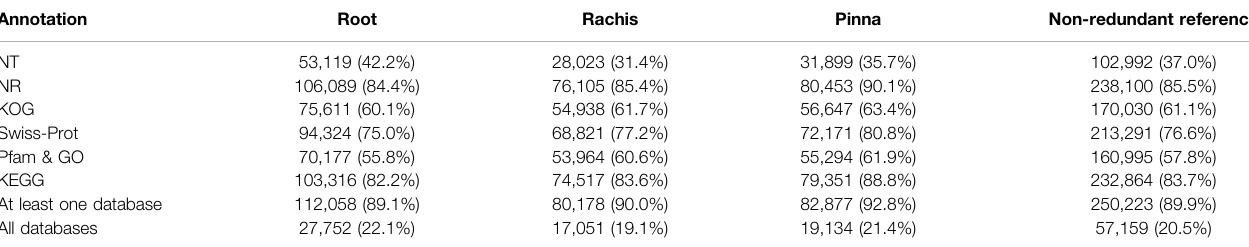
TABLE 2 | Statistics for the annotated results of FL transcriptomes in the public databases